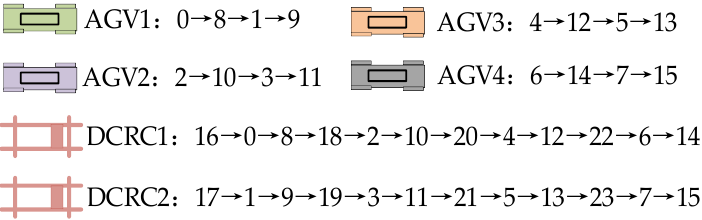
Figure 7. AGV and DCRC task assignments. Coevolution was first proposed by Ehrlich and Raven. In this process, different pop- ulations have different evolutionary goals, and they can complement each other with in- formation, have strong global search ability, and overcome the phenomenon of a single population and premature convergence in the later stage of the GA [46–48].